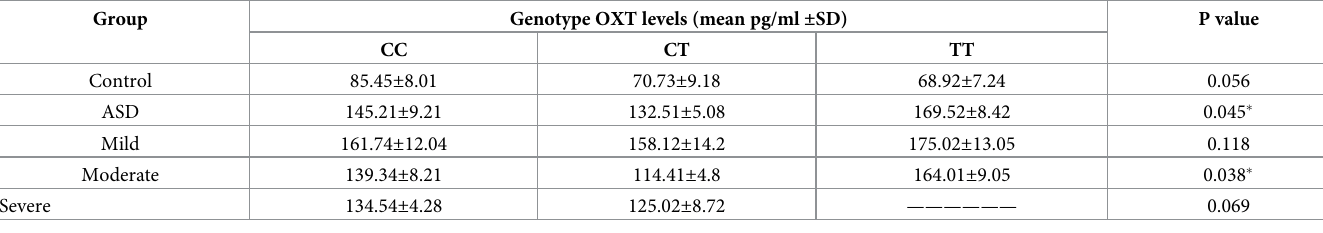
Table 7. OXTR polymorphism rs2268491 in ASD severity categories.